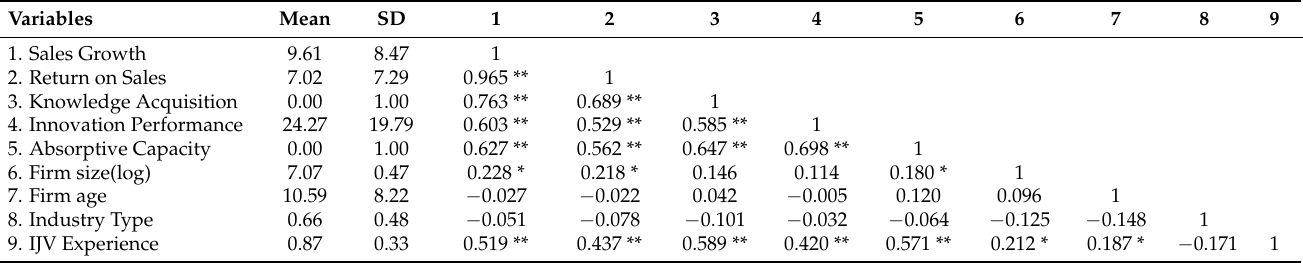
Table 1. Descriptive statistics and correlation matrix ( n =